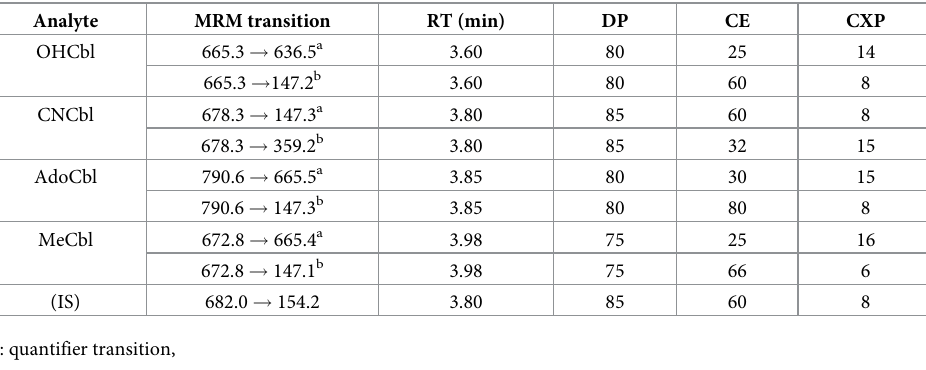
Table 2. Specific MRM parameters and retention times (RT) for each analyte and internal standard